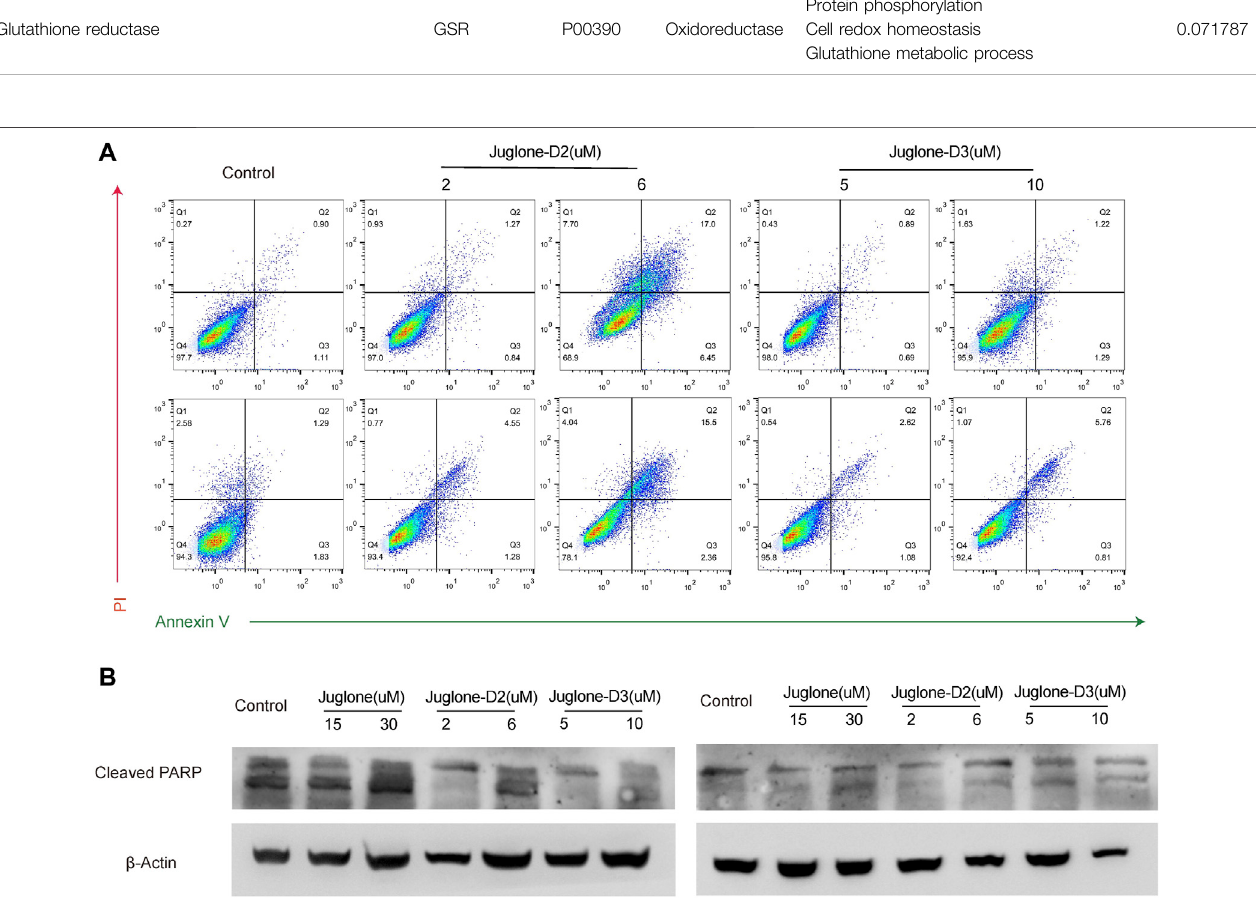
FIGURE 5 | Juglone derivatives could induce apoptosis of glioma cells. (A) Flow cytometry detection showed D2 and D3 induced glioma cell apoptosis. (B) Western blot assay showed the expression level of cleaved-PARP was increased after D2 or D3 treatment on U87 and U251 cells.